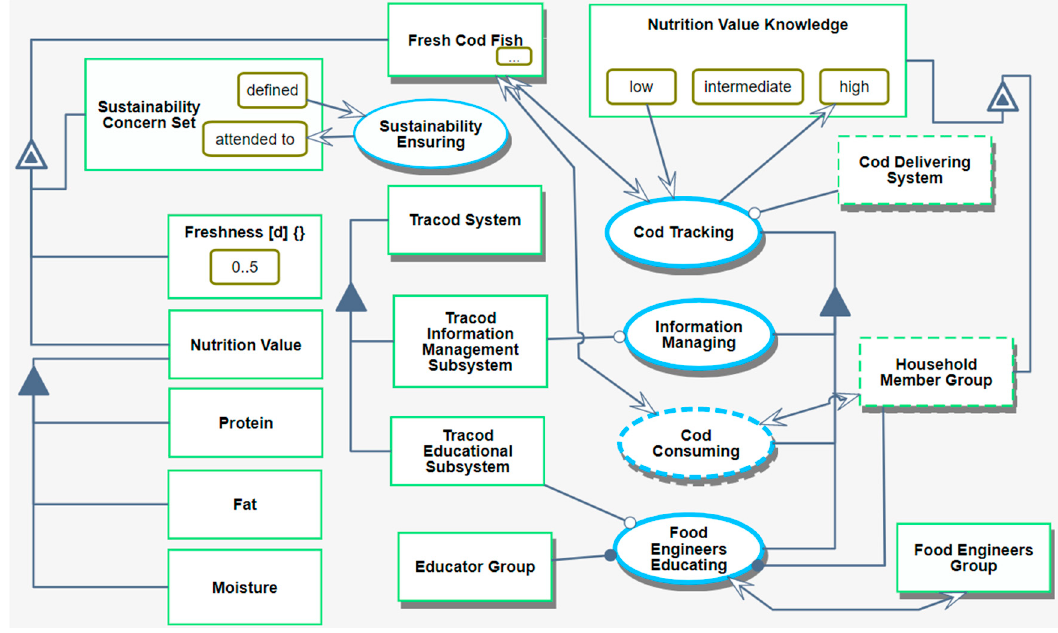
Figure 4. SD1—The first detail level of the codfish supply chain OPM model whose SD is in Figure 3 .